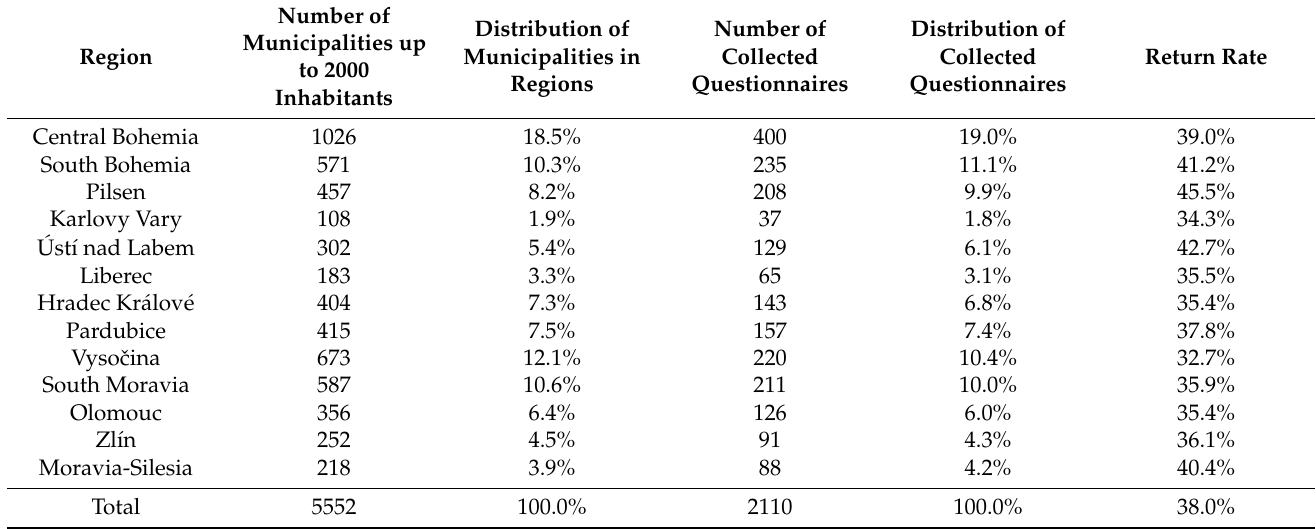
Table 2. Overview of the number of municipalities and collected questionnaires in individual